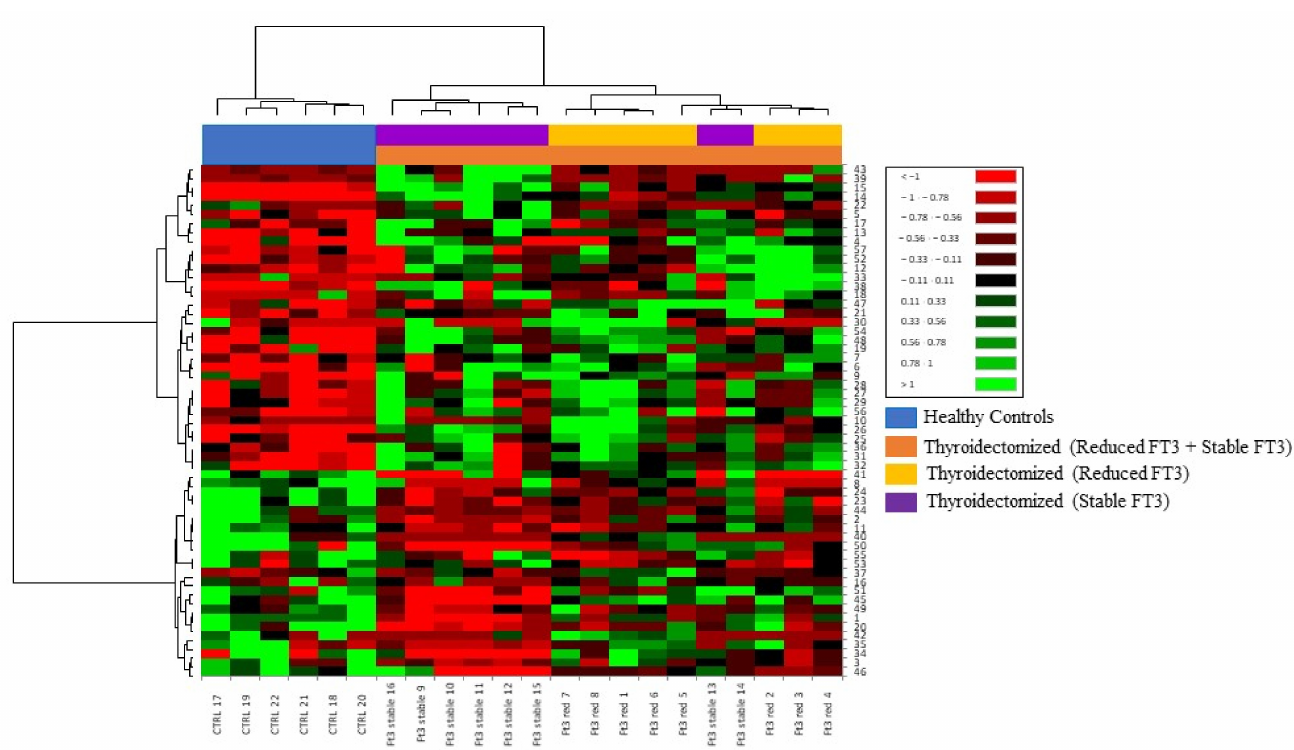
Figure 5. Heatmap branching of the 57 DASs separates samples into two principal clusters corre- sponding to thyroidectomized (orange bar) and control groups (blue bar). The thyroidectomized group is furtherly subdivided in two groups corresponding to reduced FT3 (yellow bar) and stable FT3 (purple bar). Numbers on the right of the heatmap correspond to the spot numbers of differential proteins reported in Table 3. Protein abundance in the heatmap goes from brilliant green (highly abundant) to red (lowly abundant) as shown on the scale reported on the